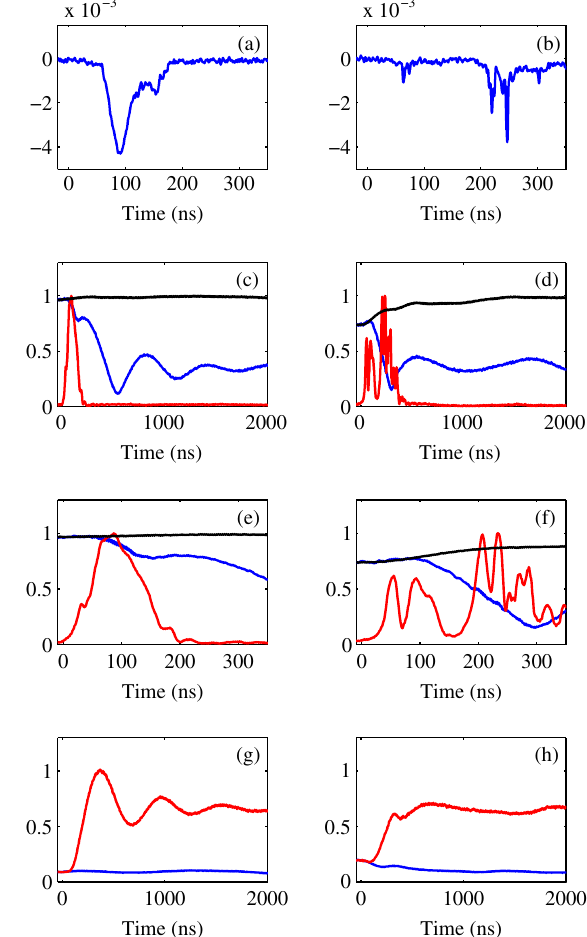
FIG. 3. Radio frequency breakdown without laser trigger of single-breakdown event (left) and multiple-breakdown event (right). (a),(b) The Faraday cup signal in Amperes. (c),(d) Nor- malized FFTamplitude of the pickup signal in different frequency bands as a function of time, including the fundamental mode without breakdown (black line), the fundamental mode with breakdown (blue line), and the 8.6 GHz HOM with breakdown (red line). (e),(f) Same signals in (c),(d) with a zoom-in view around 0 ns. (g),(h) Normalized FFT amplitude of the reflection signal, including the fundamental mode without breakdown (blue line) and with breakdown (red